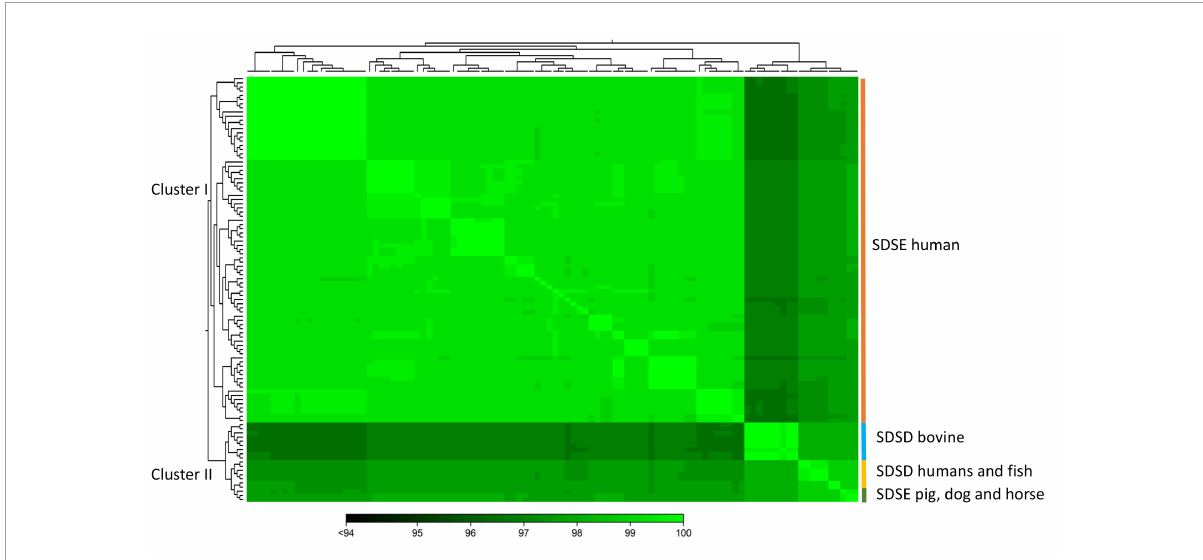
FIGURE3 The heatmap chart generated from distances calculated based on the ANI values of S. dysgalactiae core genome. The colors in the heatmap represent pairwise ANI values, with a gradient from dark green (low identity) to light green (high identity). The dendrogram directly reflects the degree of identity between genomes increasing in similarity from dark to green. Heatmap and dendrogram of ANI values were performed using the CLC Genomic